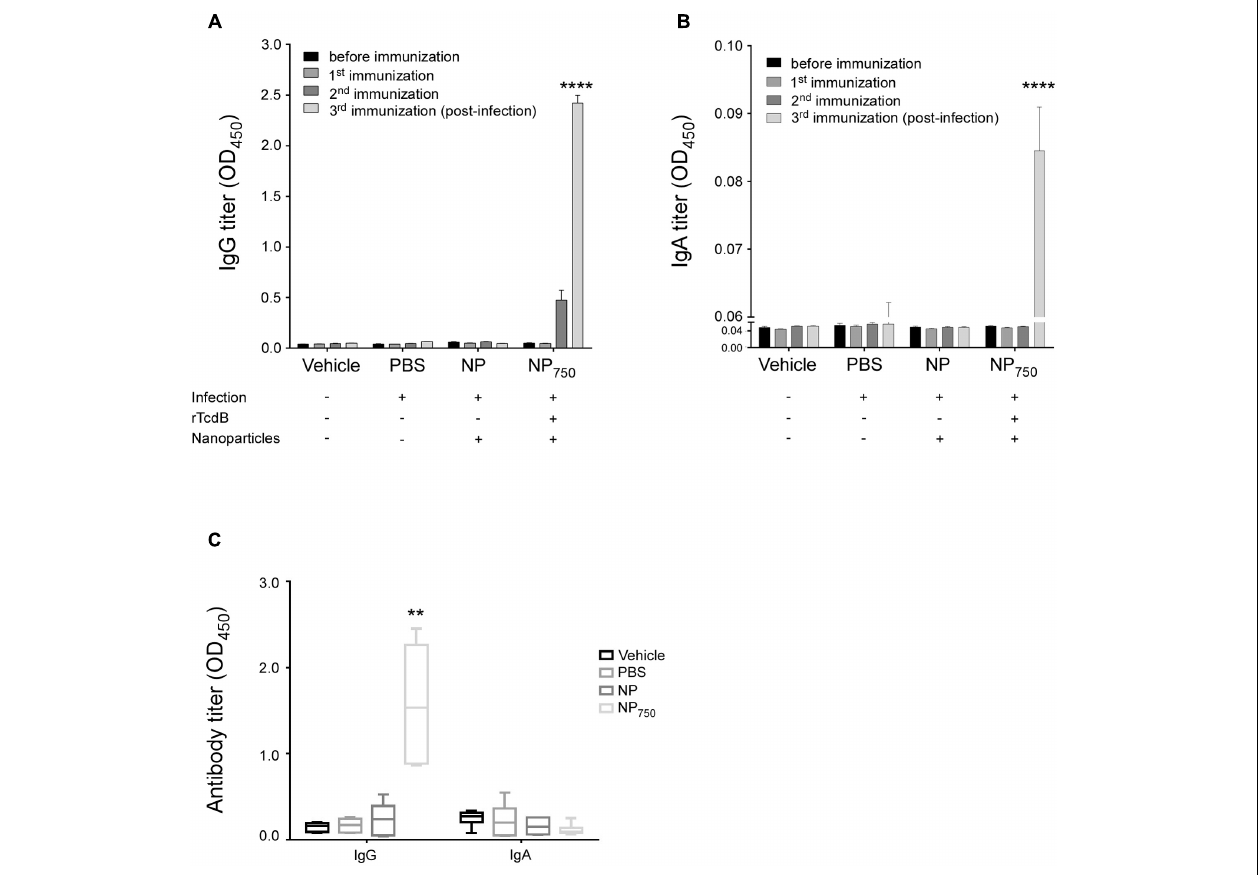
FIGURE 7 | Presence of antigen-specific IgG and IgA in NP-rTcdB vaccinated mice after C. difficile challenge. rTcdB-specific IgG (1:20,000 dilution) (A) and IgA (1: 1,000 dilution) (B) from serum of different treatment groups were compared by ELISA. (C) rTcdB-specific IgG and IgA from gastrointestinal lavage (GAL) (1:2 dilution) were also compared. All data are presented as mean ± standard deviations. Statistical comparisons between NP-rTcdB vaccinated and empty nanoparticle vaccinated group were analyzed by Student’s t -test ( ∗∗ P ≤ 0.01, ∗∗∗ p ≤ 0.001, ∗∗∗∗ p ≤ 0.0001). All data are representative of at least three independent